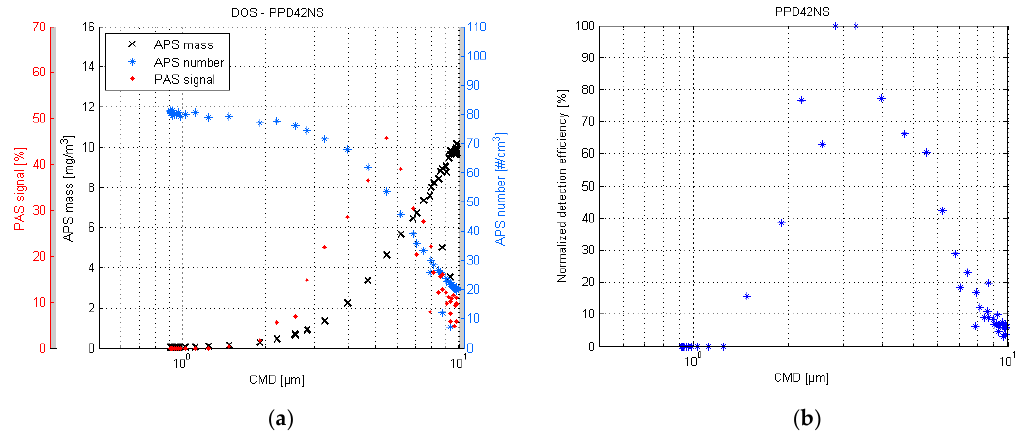
Figure 3. PPD42NS response plot of the DOS test ( a ) and the respective normalized detection efficiency scatter plot ( b ).